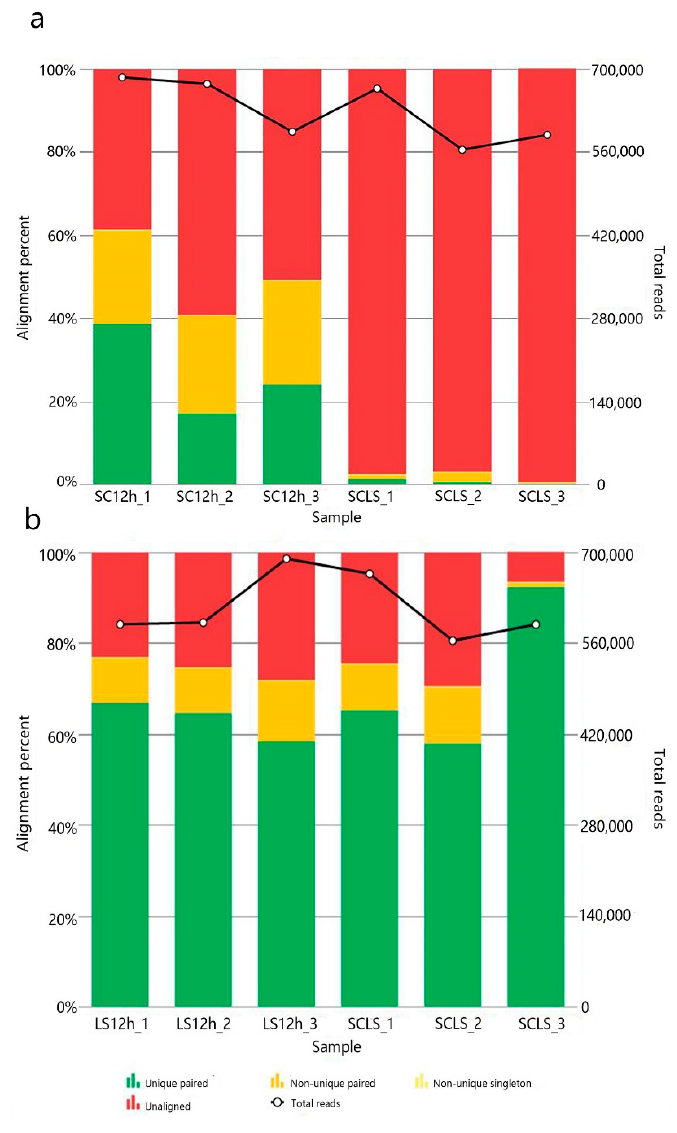
Figure 4. Alignment of the sequenced reads to the reference genome of S. cerevisiae S288C ( a ) and F. sanfranciscensis TMW 1.1304 ( b ). SC12h: S. cerevisiae 9Y3 fermentation for 12 h; LS12h: F. sanfrancis- censis LS1 fermentation for 12 h. SCLS: co-fermentation of S. cerevisiae 9Y3 and F. sanfranciscensis LS1.